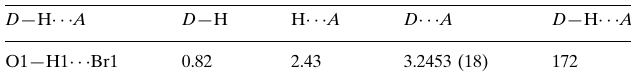
Hydrogen-bond geometry (A˚ , (cid:3)